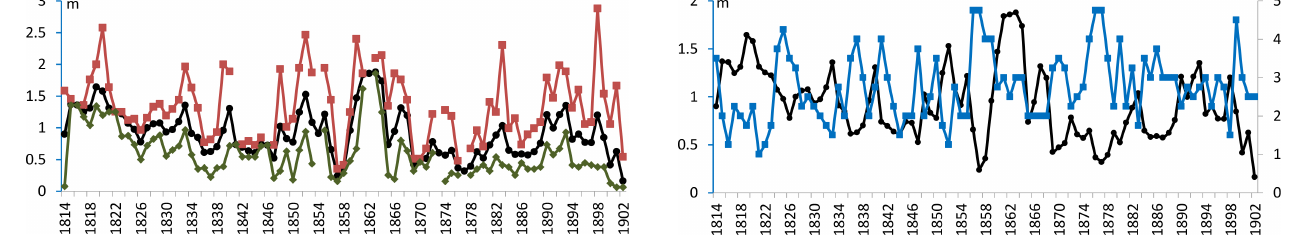
Figure 3. The thick blue line with squares denotes the average dryness–wetness index (hereinafter DWI) of four stations in the vicinity of Lake Machang, namely Heze, Jinan, Linyi and Xuzhou. DWI is a five-grade dataset: 5 (very dry), 4 (dry), 3 (normal), 2 (wet) and 1 (very wet). The thin black line with dots denotes the annual mean water level of Lake